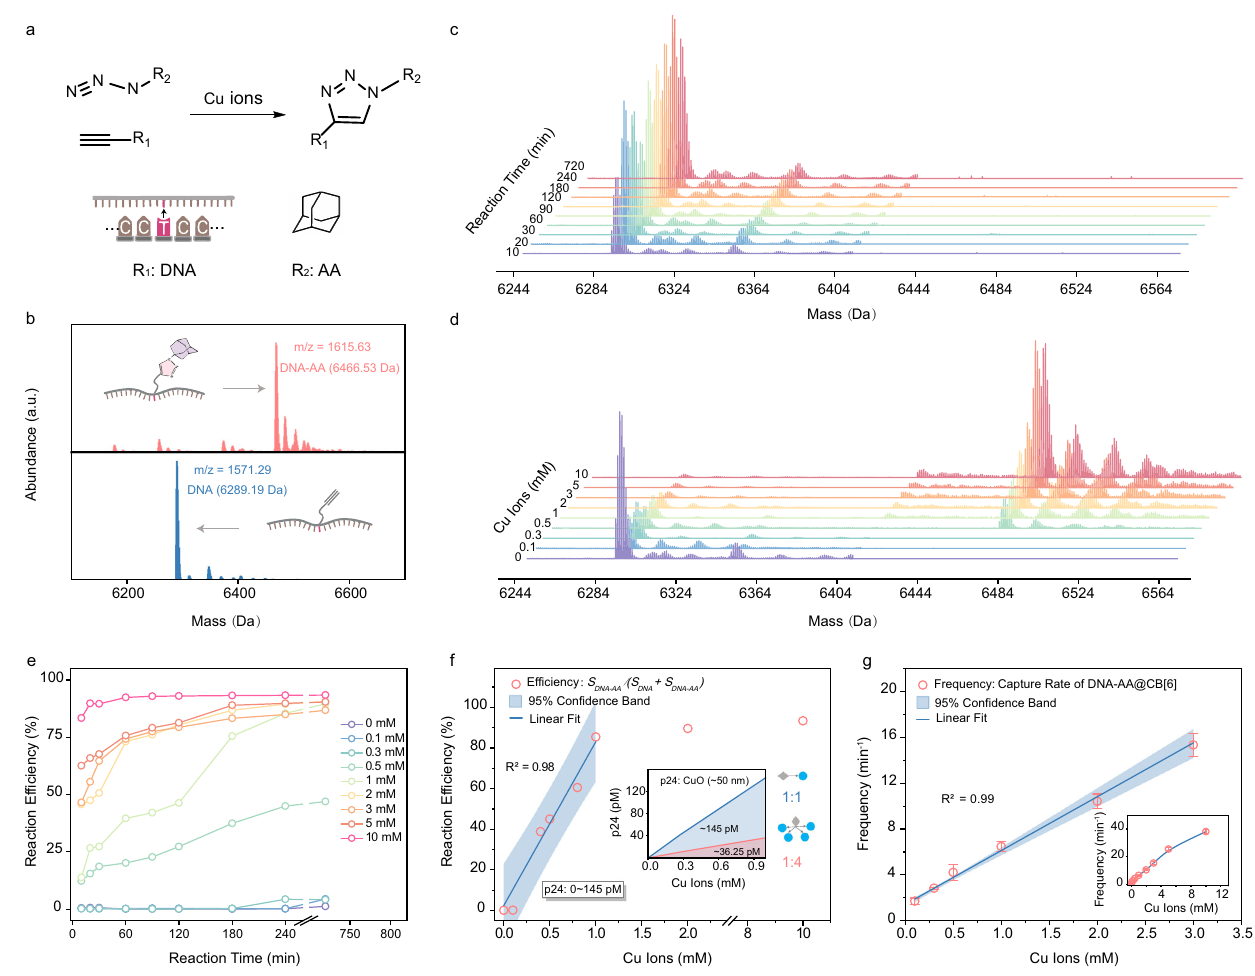
Fig. 3 | Click reaction catalyzed by Cu + ion. a Scheme of Cu + ion-catalyzed click reaction between alkynes (R 1 ) and azides (R 2 ). b MS characterizations of the sub- strate (alkyne modi fi ed DNA) and the product (DNA-AA) of the click reaction. c , d MS characterizations of the substrate and the product of the click reaction c under different reaction time in absence of Cu + ions and d under the same reaction time with different Cu + ion concentrations. e Reaction ef fi ciency as a function of reaction time in presence of various Cu + ion concentrations. Reaction ef fi ciencyisdeterminedbyS DNA-AA / ( S DNA +S DNA-AA ) (S:integratedpeakareainmass spectrum). f Reaction ef fi ciency as a function of Cu + ion concentrations under 4h reaction time with linear fi t between 0mM and 1mM Cu + ions. Each data point obtained between 0 mM and 1mM Cu + ions (Fig. 3f). Theoretical p24 concentrations corresponding to this range are 0~145 pM and 0~36.25 pM for 1:1 and 1:4 p24 antigen-CuONP ratios, respectively (Inset of Fig. 3f), to cover quanti fi cation needs in most clinical scenarios (0.42-